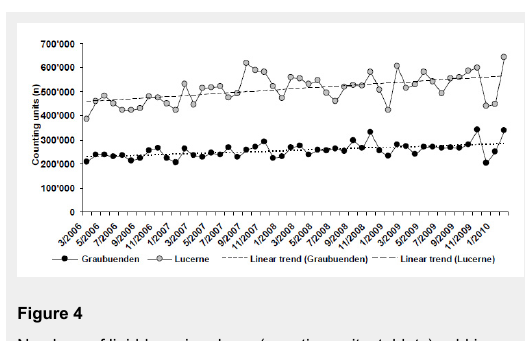
Numbers of lipid-lowering drugs (counting units; tablets) sold in Graubünden and Lucerne from March 2006 to February 2010. The dashed lines show the overall trends in sales figures for the respective region over time. (Data are courtesy of IMS Health GmbH,